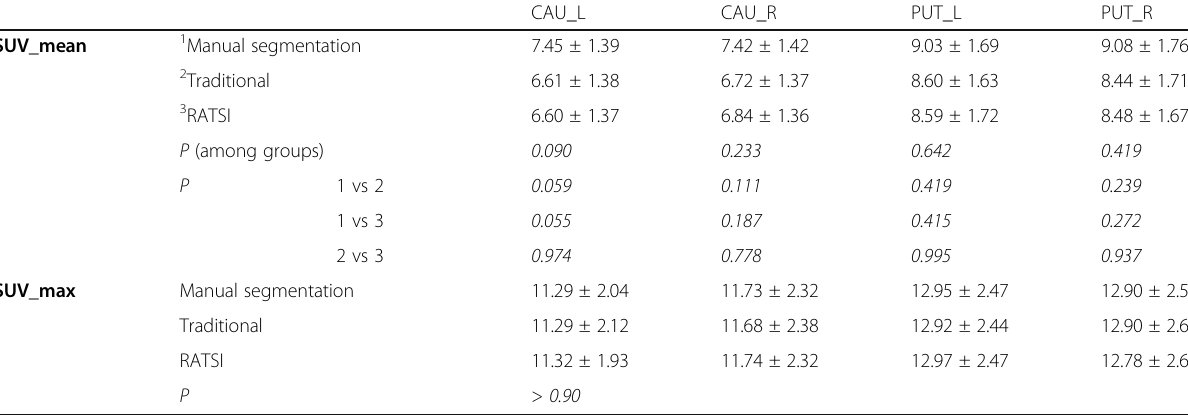
Table 2 The lists of mean and max 18 F-FDG-SUVs in segmented regions extracted with manual segmentation, RSIAT, and